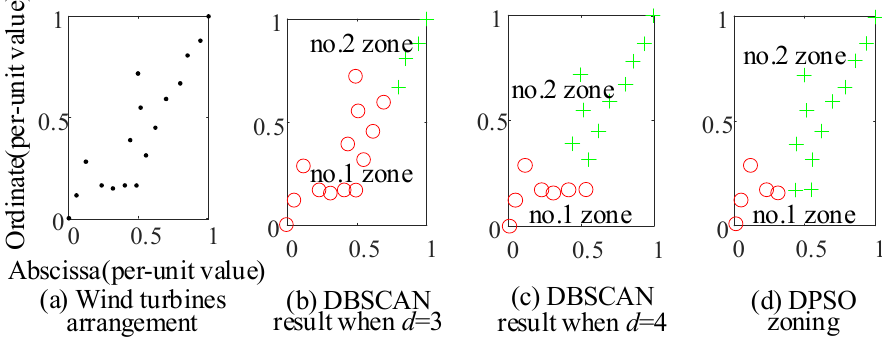
Figure 7. Comparison of zoning results based on DBSCAN and DPSO algorithm. For clustering zoning without label, silhouette coefficient is generally considered to objectively evaluate zoning results [19]. The value range of silhouette coefficient is [–1, 1], the closer it is to 1, the better zoning effect is. Comparison of silhouette coefficient based on DBSCAN and DPSO algorithm is shown in Table 2. It can be seen that the silhouette coefficient of the DPSO zoning result is the largest, which proves that the zoning result is the optimal objectively. In addition, when d = 4, the DBSCAN zoning result is close to DPSO zoning, and the corresponding silhouette coefficient is suboptimal. The results